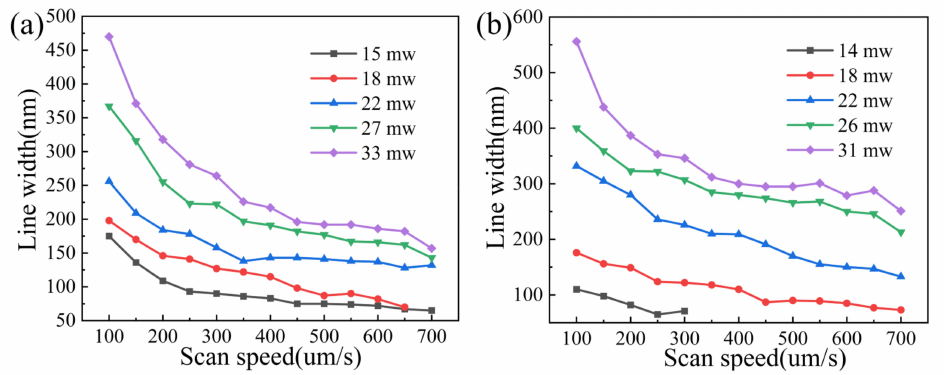
Figure 4. The effect of laser processing parameters on the width of the DLW processed red QD–polymer suspended lines ( a ) and green QD–polymer suspended lines ( b